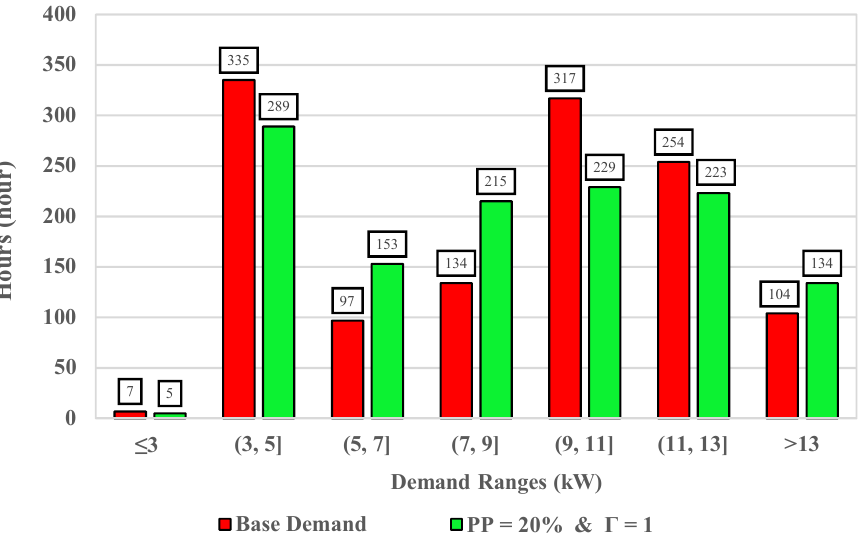
Figure 8. Comparison of statistical demand dispersion for a one-year horizon after DRP imple- mentation.